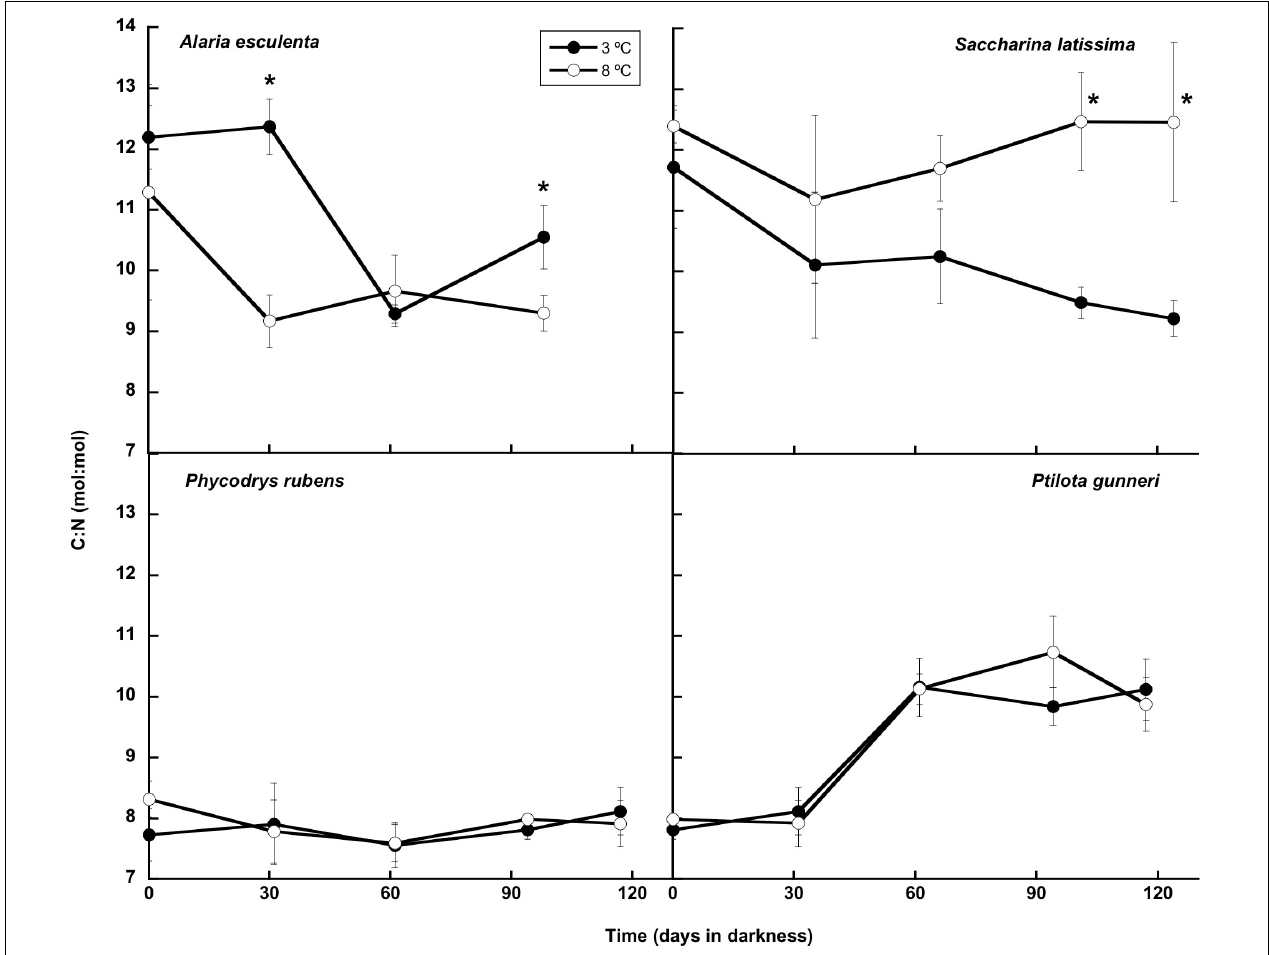
FIGURE 9 | C:N molar ratio during the 16 weeks of incubation in darkness of Alaria esculenta , Saccharina latissima , Phycodrys rubens , and Ptilota gunneri at two different temperatures. Data are mean of 5 replicates (error bars for standard deviation). Significant differences between temperatures marked with an